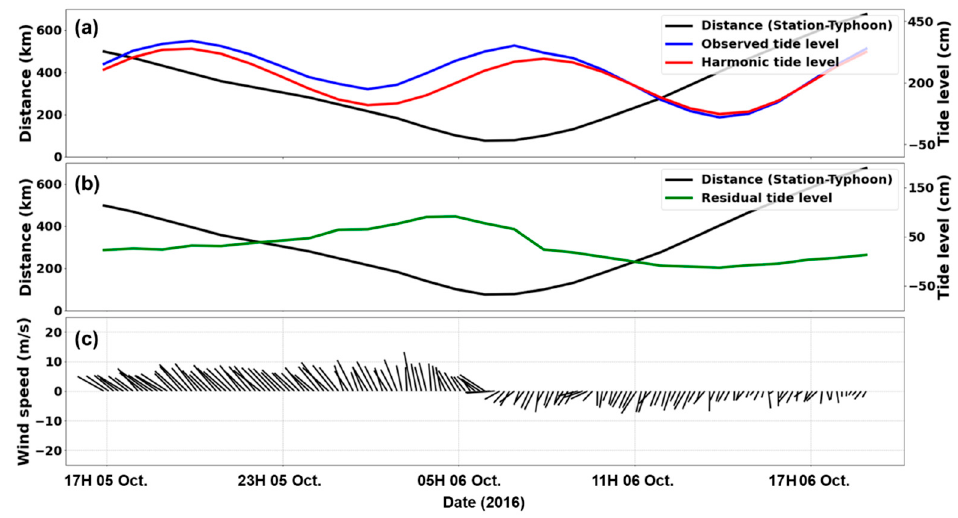
Figure 14. Time-series of observational data from Wando tidal station during Typhoon Kong-Rey. ( a ) Astronomical tide, ( b ) residual tide level, and ( c ) wind components, where direction and length represent wind direction and speed, respectively.